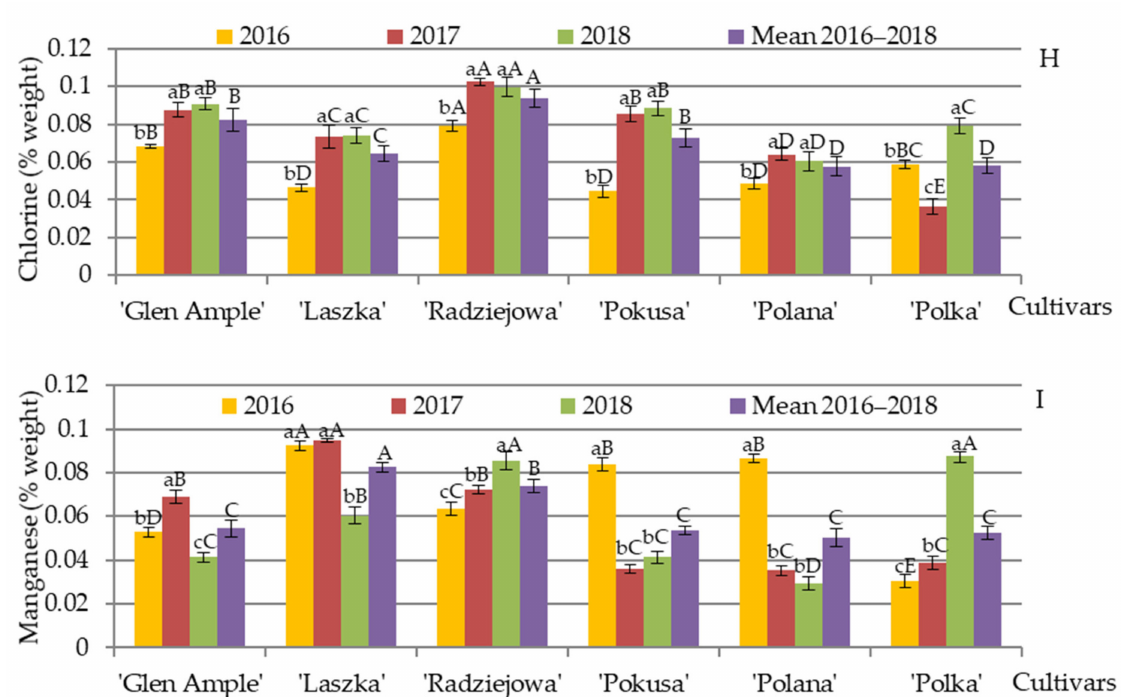
Figure 14. ( A – I ) . Content of selected elements in the pollen exine in six Rubus idaeus cultivars. Explanations: for each element, means followed by the same small letter are not significantly different within the cultivar for the years and means followed by the same capital letter do not differ between the cultivars in each year of the study at a significance level α = 0.05; (number of repetitions in each year n = 25). Bars indicate standard deviation. The content of elements was determined with the use of energy dispersive X-ray spectroscopy